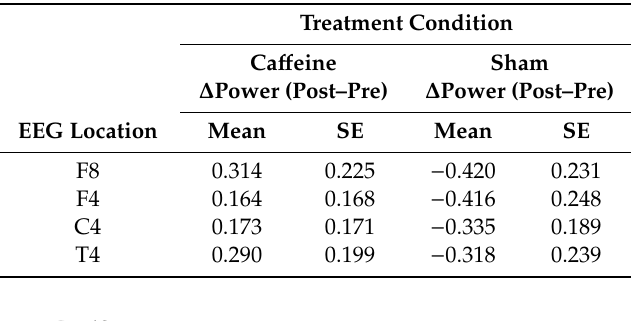
Table 1. Theta-band power differences between post- and pre-aspiration during the letter 3-back working memory task in the caffeine and sham conditions ( N = 9).